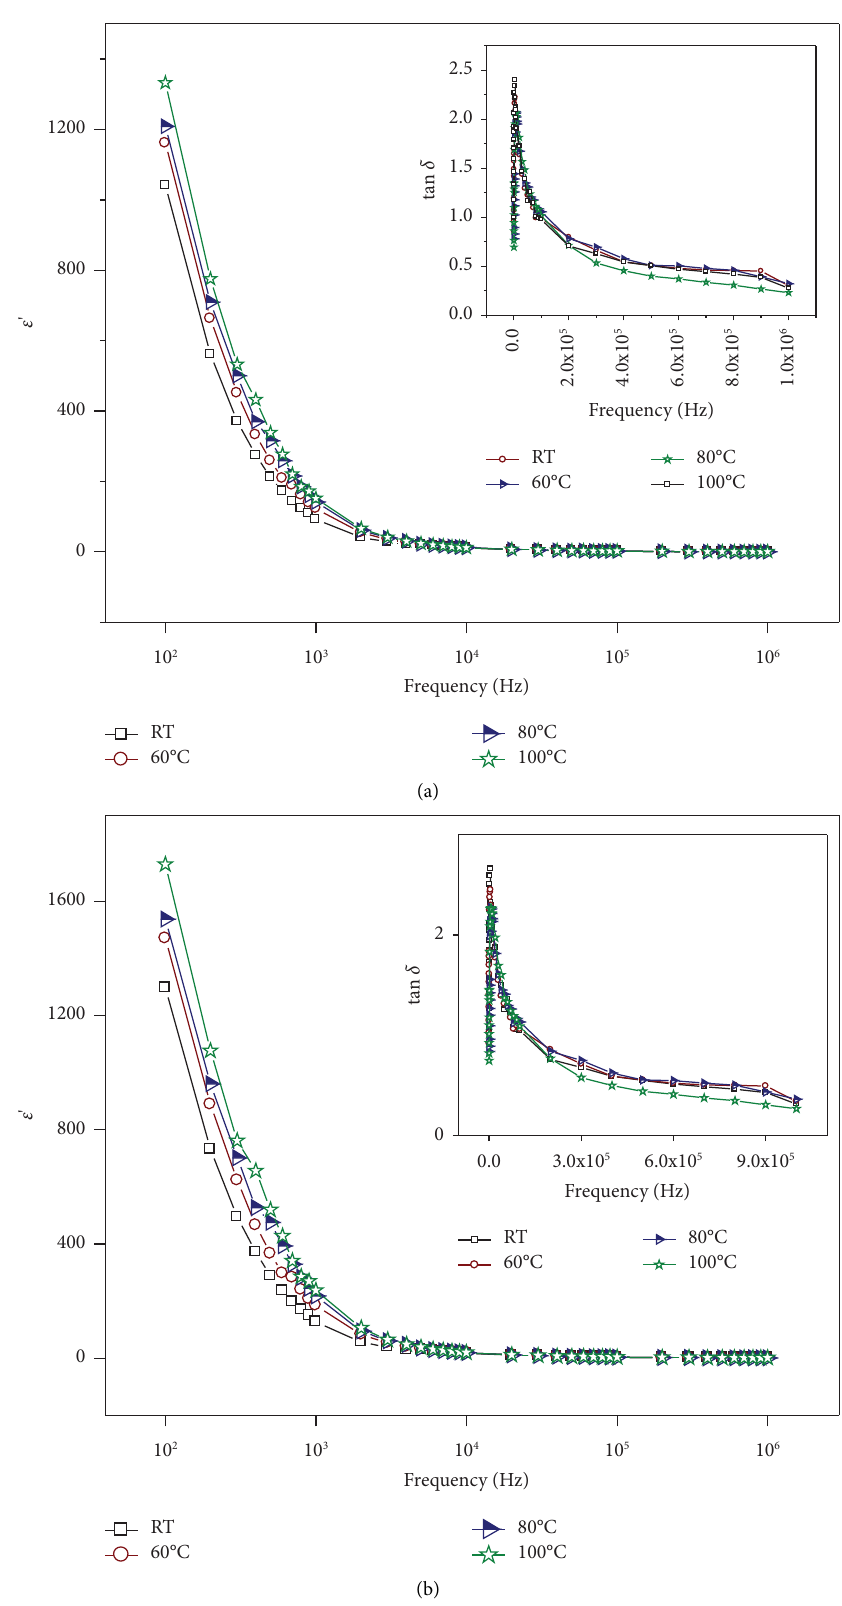
Figure 8: Dielectric constant as a function of frequency at diferent temperatures for LM (a) and LS (b) inset shows corresponding tangent